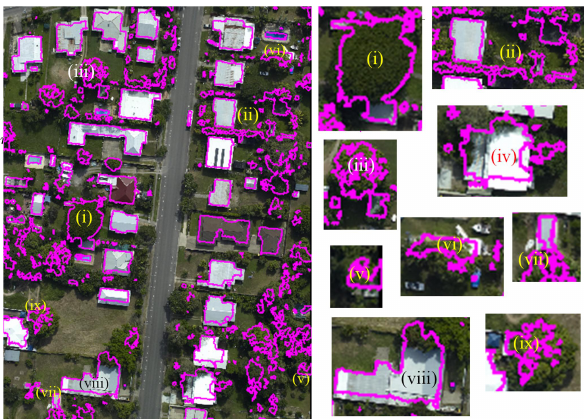
Figure 4. (a) Building after clustering process, (b) Occluded and false delineated